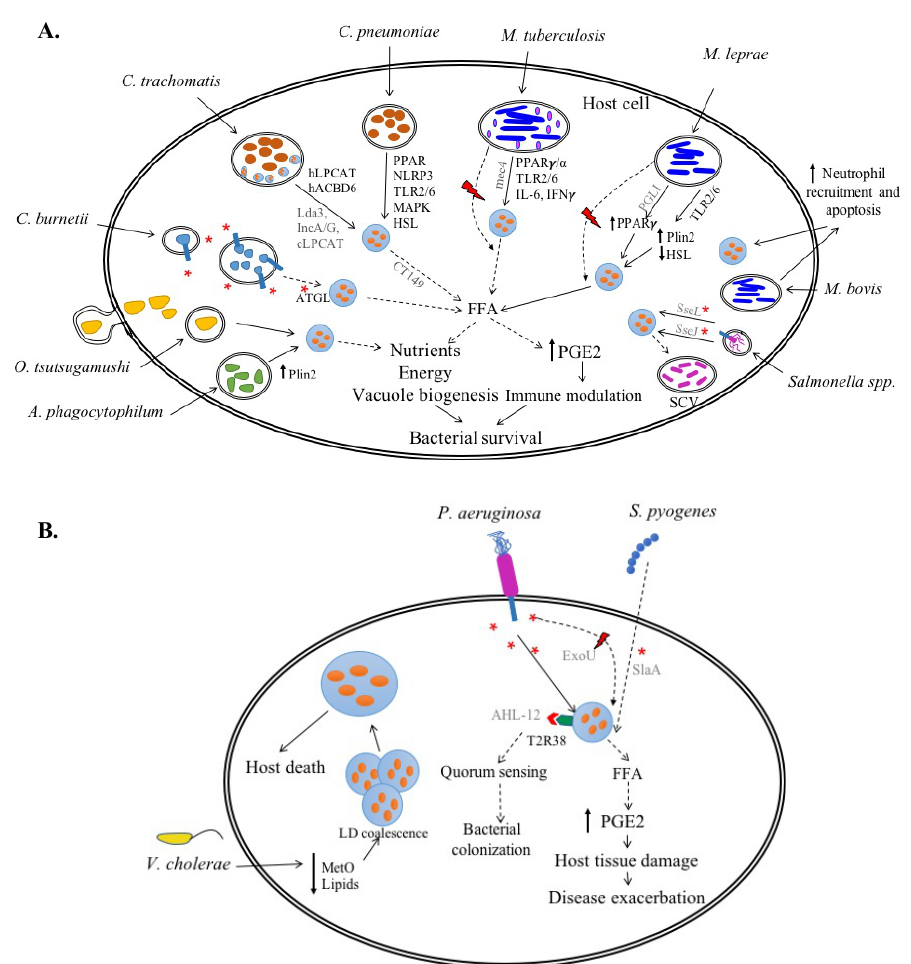
Figure 1. Overview of host LD–bacterial interactions. ( A ) Intracellular bacteria employ di ff erent host (black) and bacterial proteins (grey) to induce LD accumulation or LD lipolysis to generate free fatty acids (FFA) as a source of energy, nutrients or prostaglandin E2 (PGE2). However, the function of LDs is still unclear for most pathogens as indicated by the dotted arrows. Salmonella is hypothesized to utilize LDs for Salmonella -containing vacuole (SCV) biogenesis and host LDs translocate to C. tachomatis vacuole. Mtb is the only bacterium known thus far to synthesize bacterial LD. ( B ) Extracellular pathogen P. aeruginosa utilizes LDs to either increase PGE2 production or uses receptors on LDs for bacterial protein binding. LD coalescence in V. cholerae -infected host enterocyte is an indicator of host death. S. pyogenes is hypothesized to target LDs. * secretion system e ff ector, bacterial